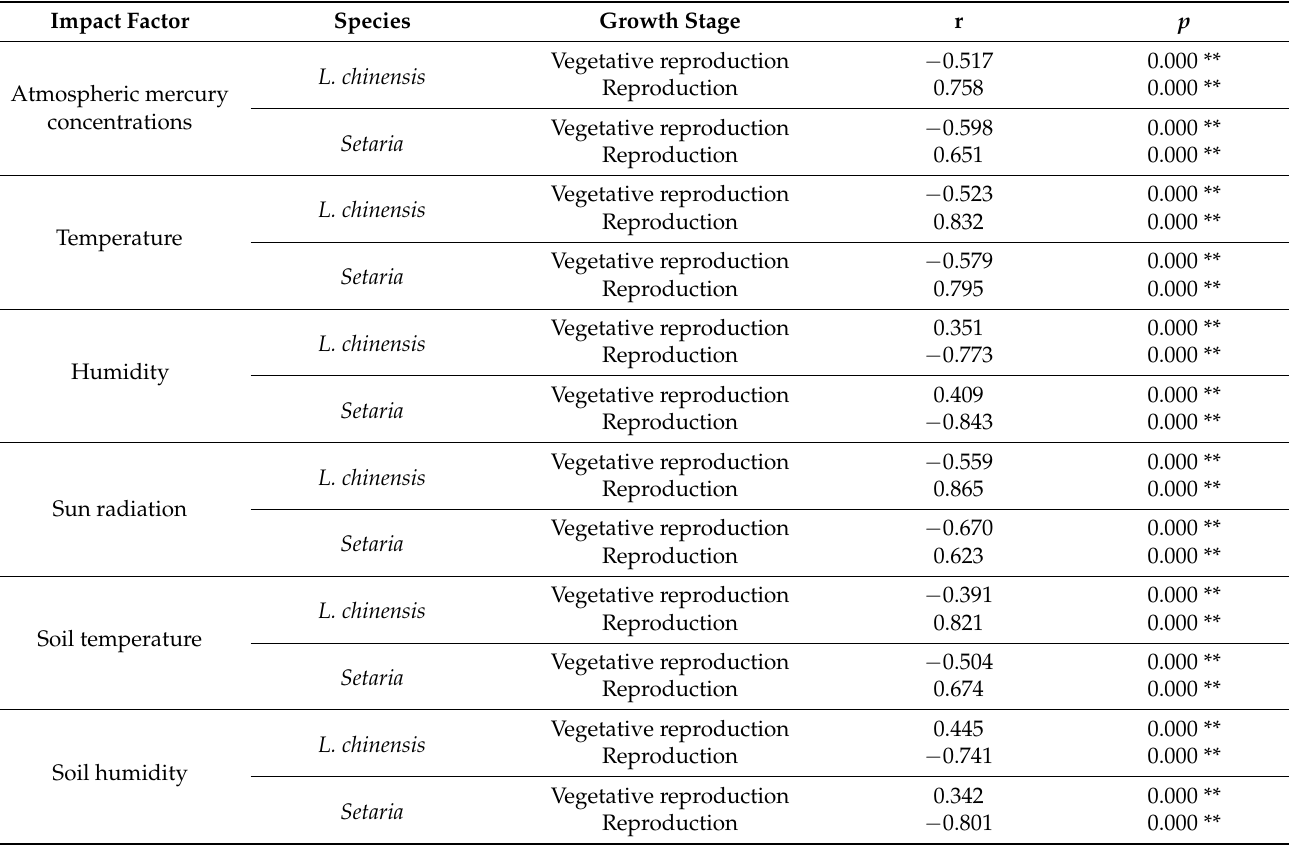
Table 6. Analysis results of linear correlations between the impact factors and the mercury